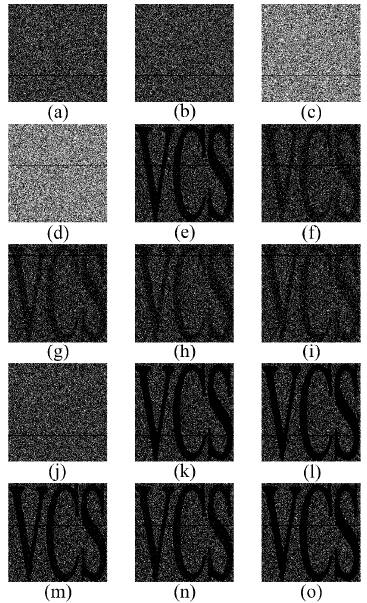
Figure 7. An experiment of the proposed (1,2,2,4)-EVCS. ( a , b ) two essential shadows; ( c , d ) two non-essential shadows; ( e ) revealed image by shadow 1 and 2; ( f ) revealed image by shadow 1 and 3; ( g ) revealed image by shadow 1 and 4; ( h ) revealed image by shadow 2 and 3; ( i ) revealed image by shadow 2 and 4; ( j ) revealed image by shadow 3 and 4; ( k ) revealed image by shadow 1, 2, and 3; (l) revealed image by shadow 1, 2 and 4; ( m ) revealed image by shadow 1, 3, and 4; ( n ) revealed image by shadow 2, 3, and 4; and, ( o ) revealed image by four shadows.